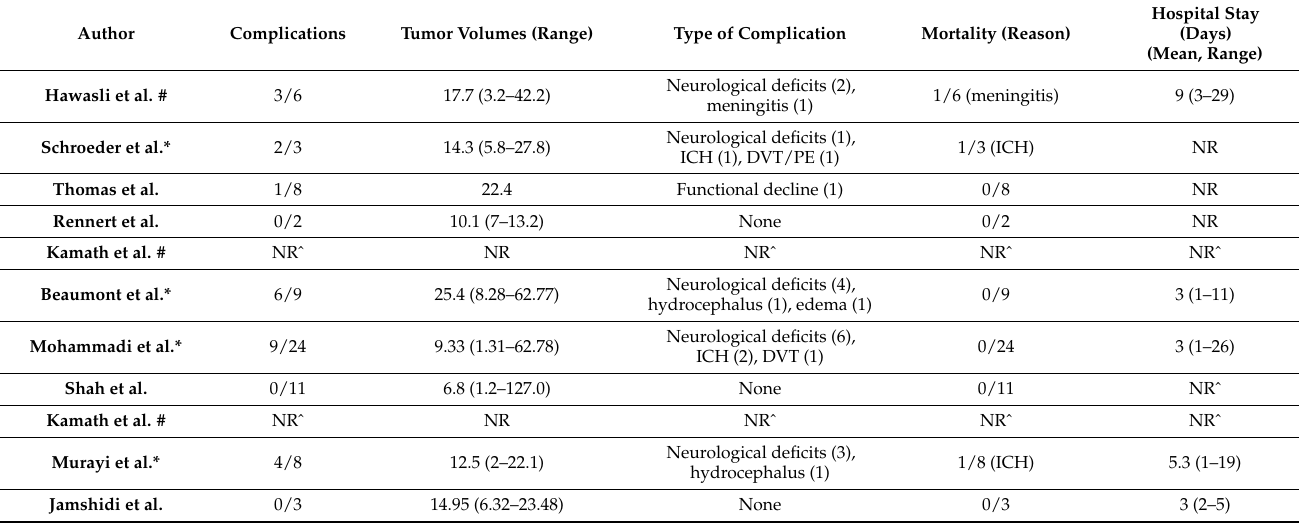
Table 5. Complications, tumor volumes, mortality and hospital